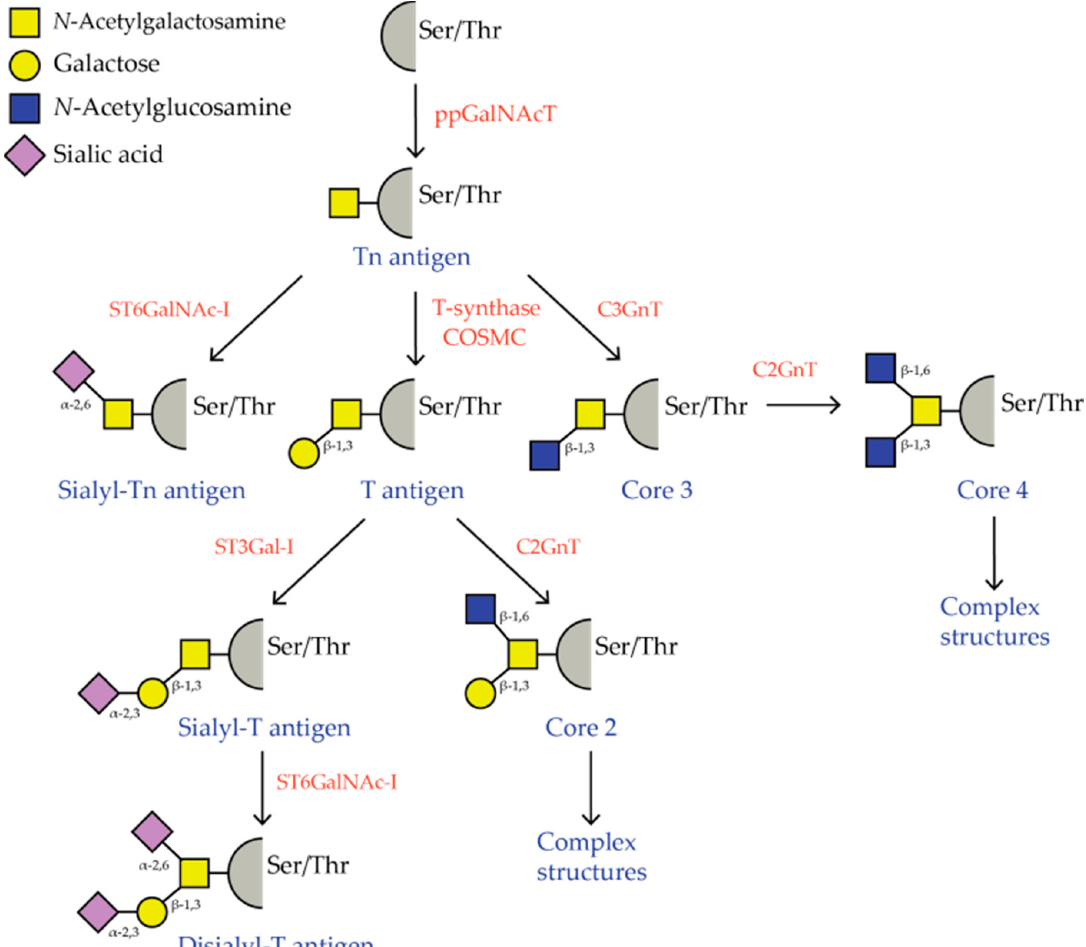
Figure 1. Overview of the O ‐ GalNAc glycosylation pathway. Glycosyltransferases are shown in red and O ‐ glycan structures in blue.